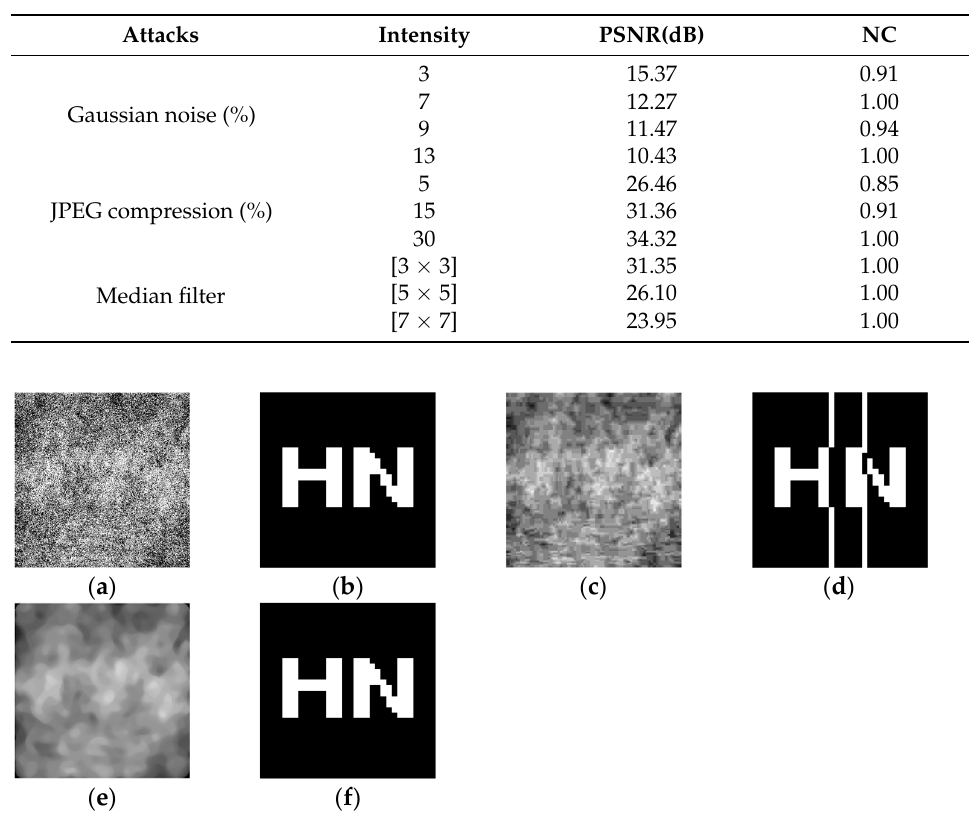
Table 3. Experimental data under conventional attack. Figure 12. Different medical images within the test ( a – h ), related encrypted images ( i–p ).